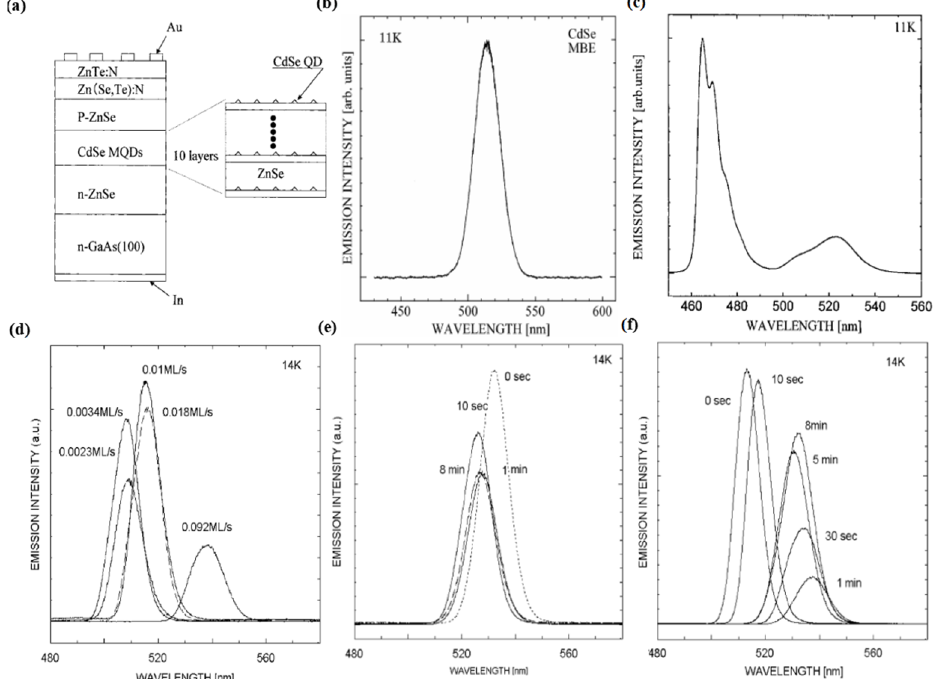
Figure 4. ( a ) Structure of the ZnSe p-n diode with CdSe multi QDs layers [35]. Copyright 2002, Physica status solidi . ( b ) PL spectrum of CdSe QDs fabricated by MBE [36]. Copyright 2000, Japanese Journal of Applied Physics . ( c ) Structure of ZnSe p-n diode with CdSe multi QDs layers [35]. Copyright 2002, Physica status solidi . ( d ) Dependence of the photoluminescence spectra on the rate of the CdSe source supply. ( e , f ) Dependence of the photoluminescence spectra on the growth interruption time between the growth of the CdSe QDs layer and the ZnSe intermediate layer at a source supply rate of ( e ) 0.01 and ( f ) 0.1 ML/s [37]. Copyright 2007, Journal of Crystal Growth .